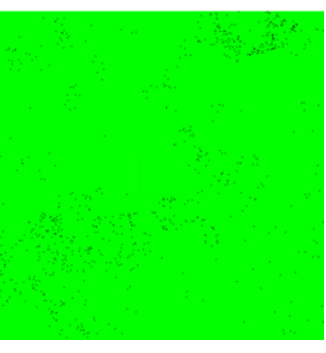
Figure 6: Durbin-Watson test – green means no significant autocorrelation (values between 1.8 and